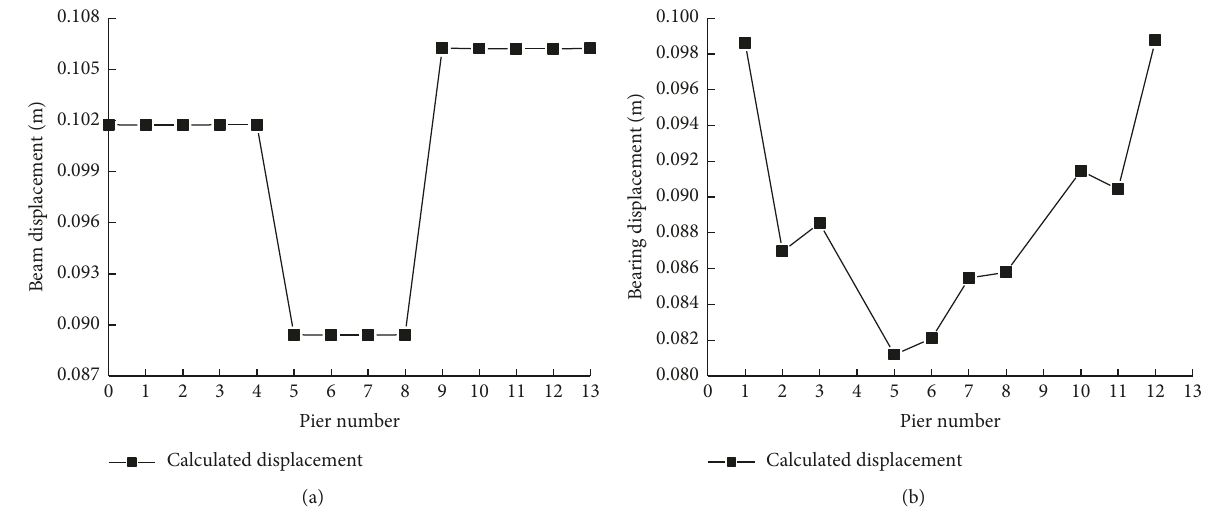
Figure 7: Displacement response of bridges under E1 earthquake. (a) Girder displacement. (b) Bearing displacement.